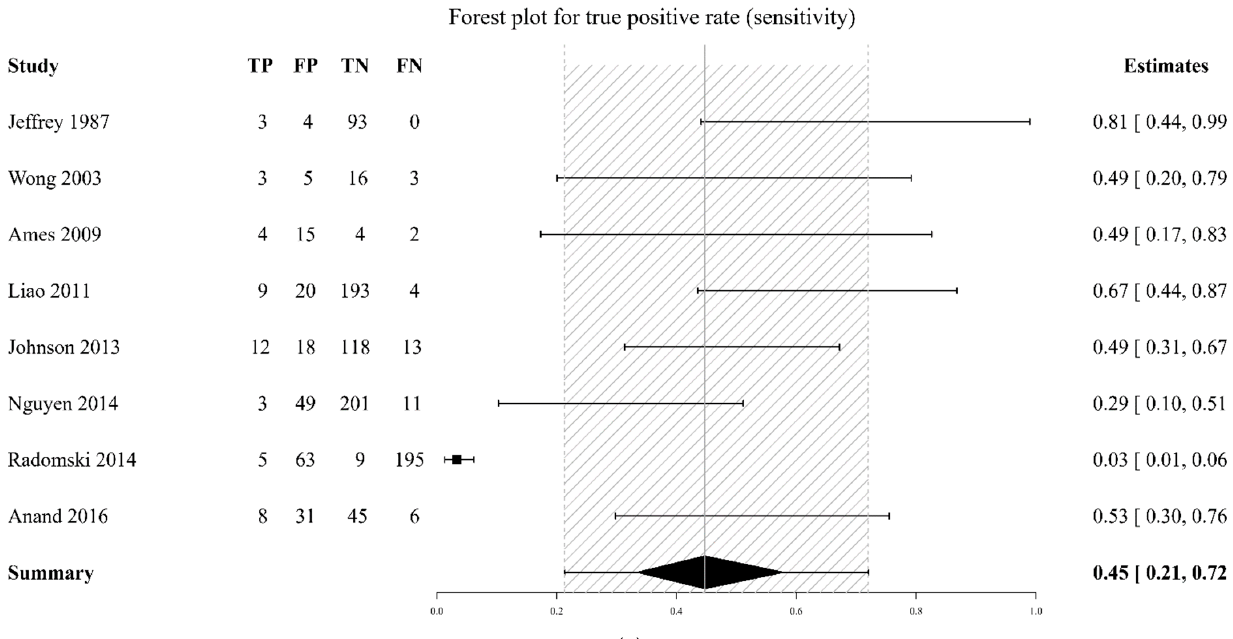
Figure 3. Forest plot of sensitivity ( a ), specificity ( b ), and diagnostic odds ratio ( c ) for shock development after computed tomography. The values of true positive (TP), false positive (FP), true negative (TN), and false negative (FN) are shown. The model-based mean estimates with 95% credible intervals are also shown [15,18–24,26].